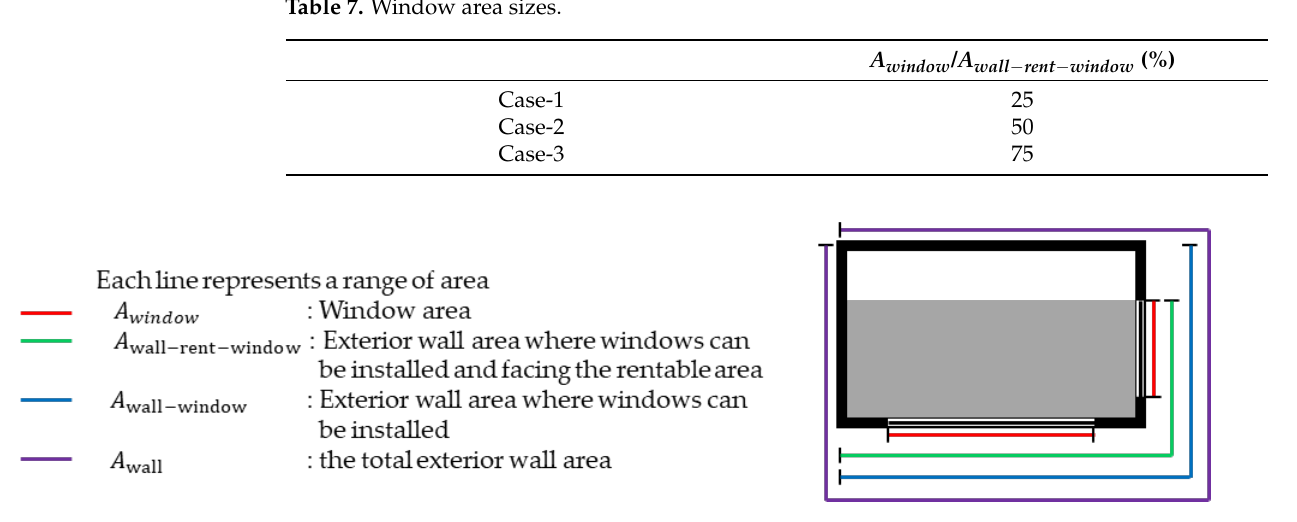
Figure 12. The respective ranges of 𝐴 𝑤𝑖𝑛𝑑𝑜𝑤 , 𝐴 𝑤𝑖𝑛𝑑𝑜𝑤−𝑟𝑒𝑛𝑡−𝑤𝑖𝑛𝑑𝑜𝑤 , 𝐴 𝑤𝑎𝑙𝑙−𝑤𝑖𝑛𝑑𝑜𝑤 and 𝐴 𝑤𝑎𝑙𝑙 .